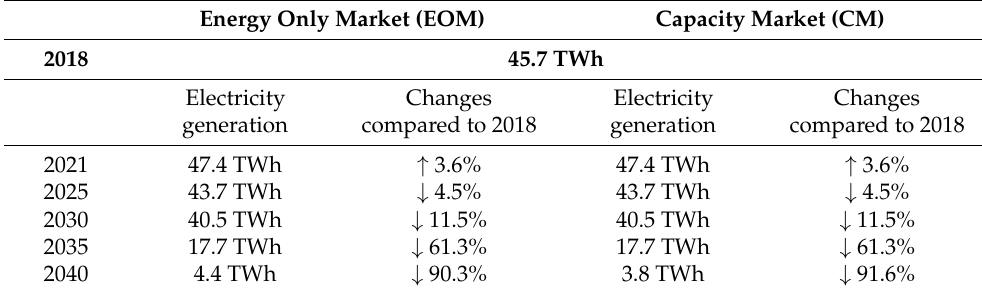
Table 7. Electricity generation in lignite-fired power units. Energy Only Market